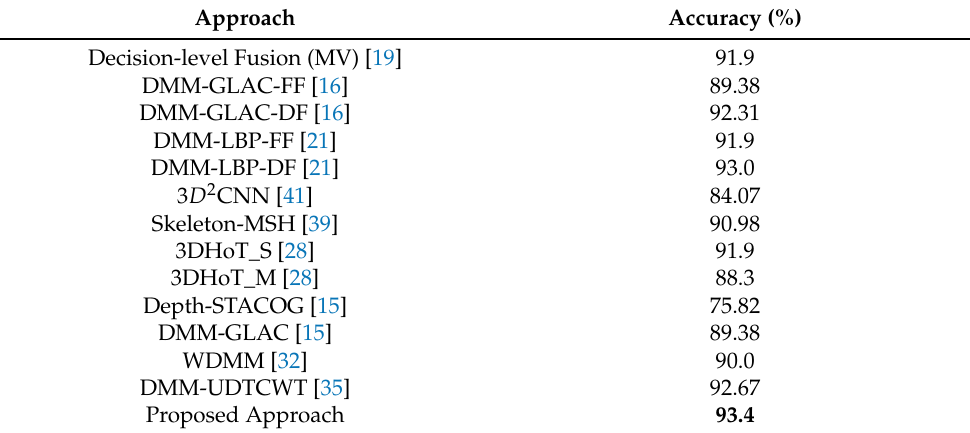
Table 1. Comparison of action recognition accuracy (%) with state-of-the-art frameworks on the MSR-Action 3D dataset.